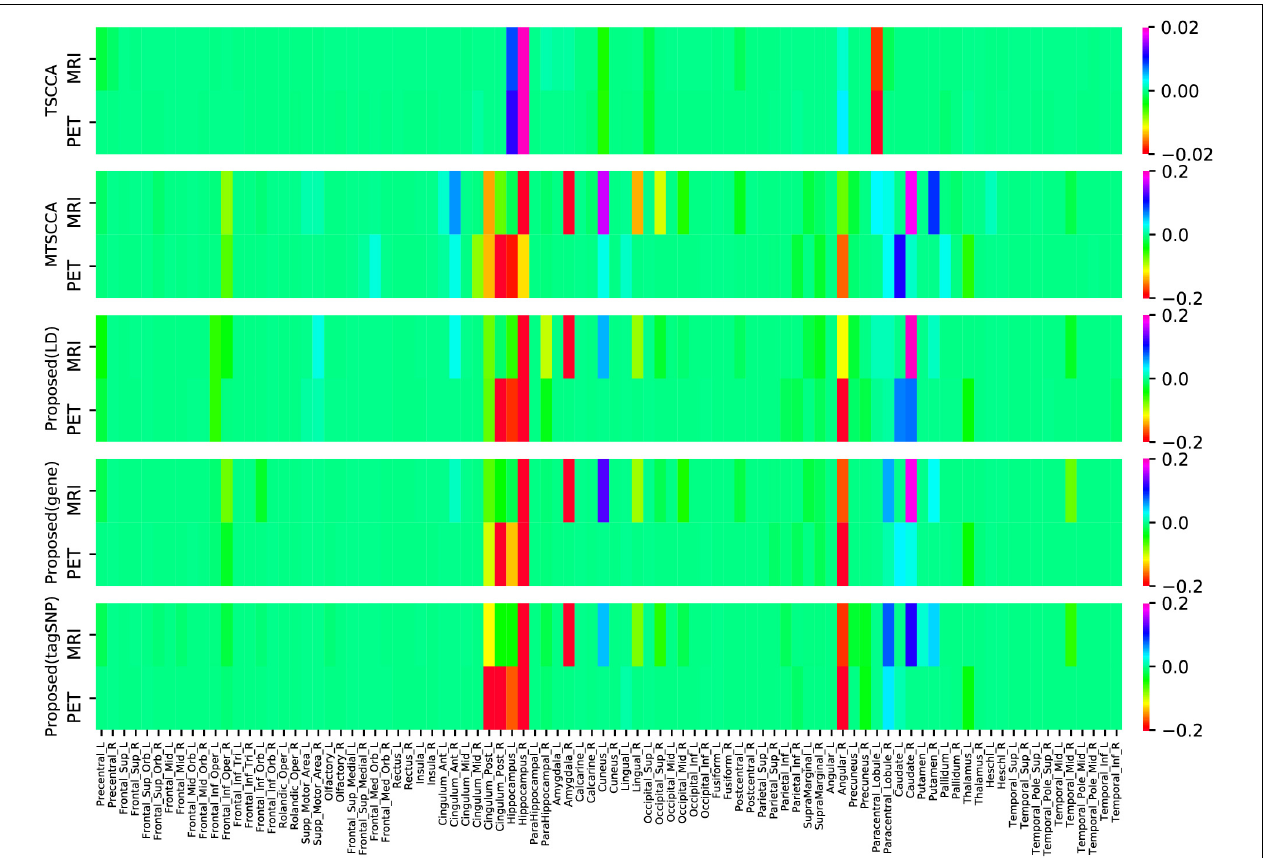
FIGURE 5 | Comparison of estimated canonical weights of imaging QTs. Each row represents: (1) TSCCA; (2) MTSCCA; (3) Proposed (LD); (4) Proposed (gene); (5) Proposed (tagSNP). Within each row, there are two parts represent two imaging modalities.